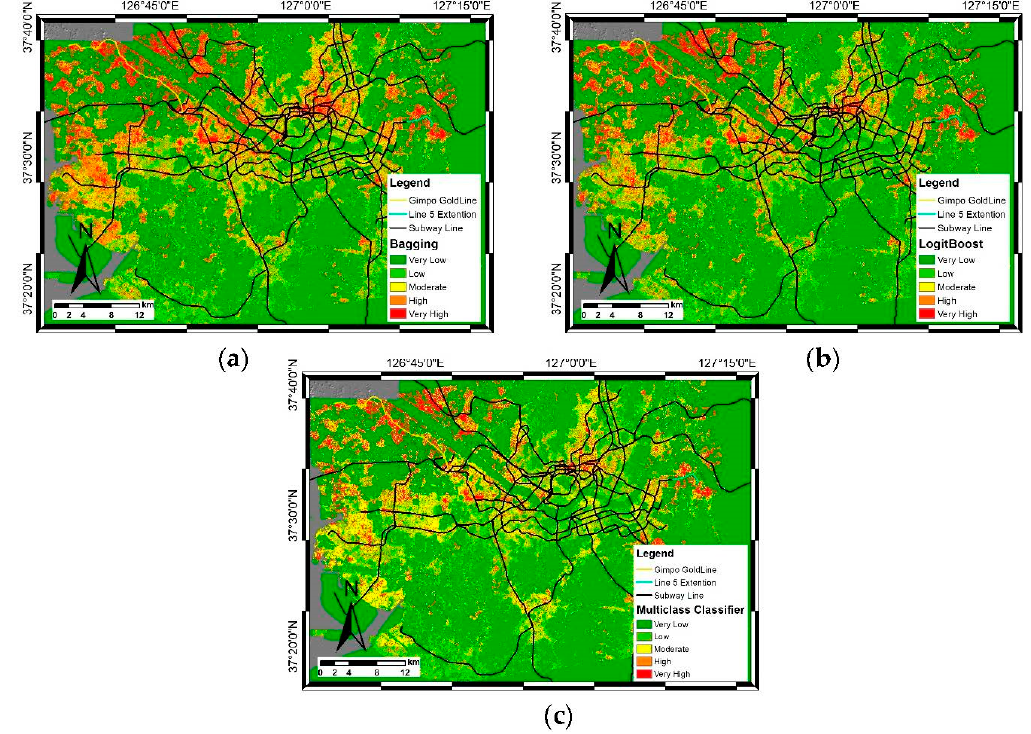
Figure 5. Land-subsidence-susceptibility map generated using three algorithms: the ( a ) Bagging, ( b ) LogitBoost, and ( c ) Multiclass Classifier algorithms.